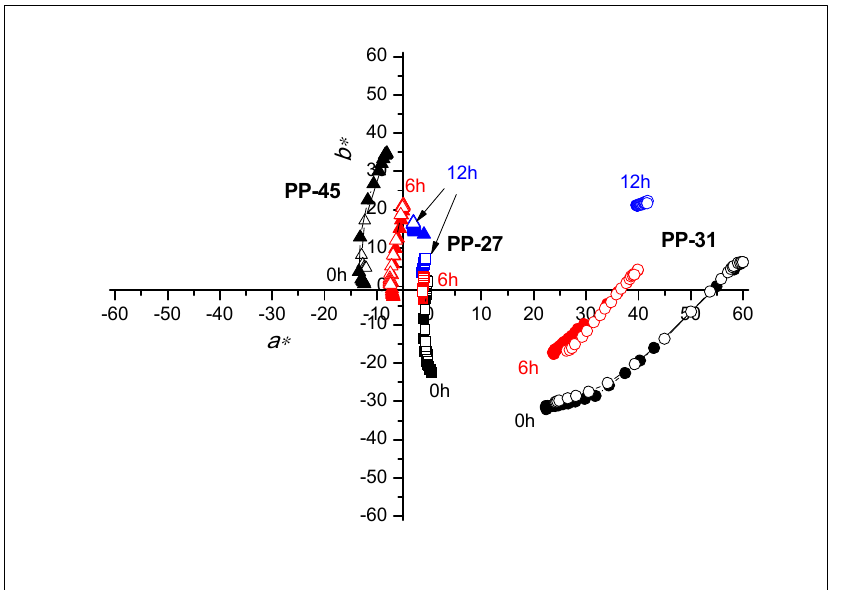
Figure 5. Changing of CIELAB values of all TC inks printed on polypropylene-based paper in the ( a *, b *) plane at heating (solid signs) and cooling (open signs).